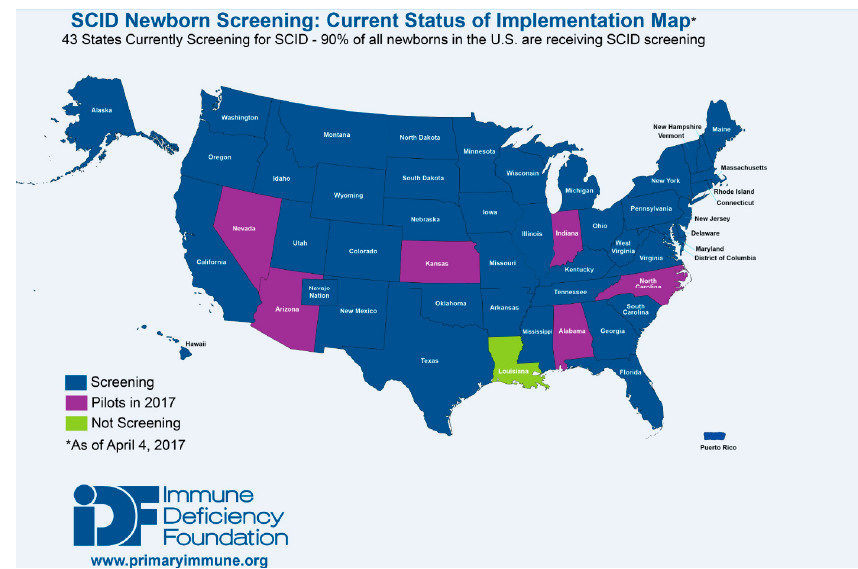
Figure 3. States currently and prospective screening for SCID as of April 2017 [38].